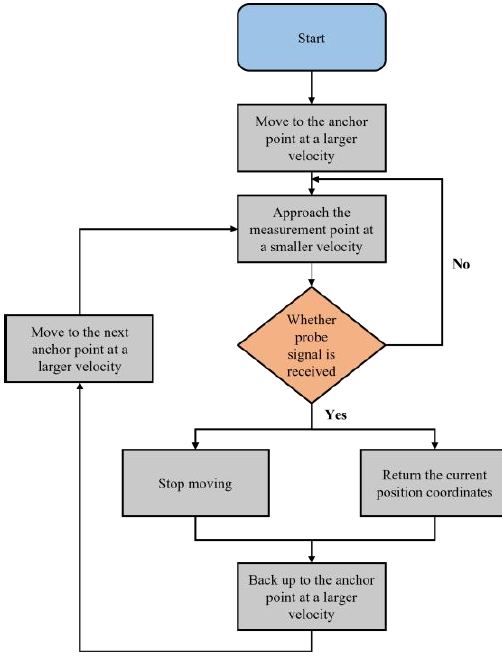
Figure 8. Measurement process flow chart.